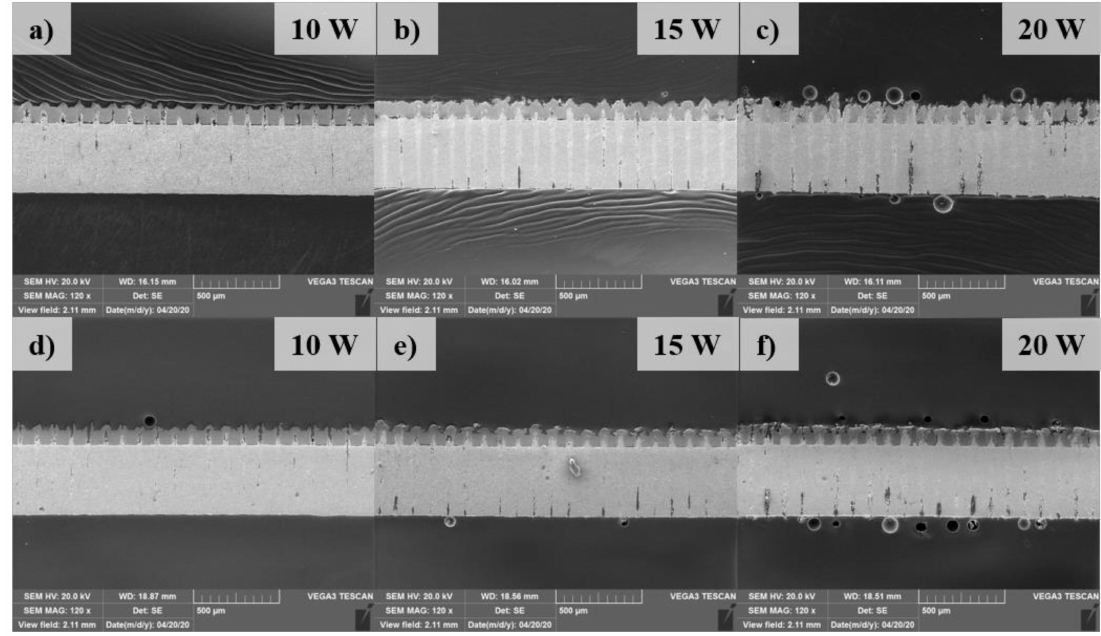
Figure 8. SEM images of the overview of the cross-section of the weld. ( a – c ): Weld without the metal tube; ( d – f ): Weld with the metal